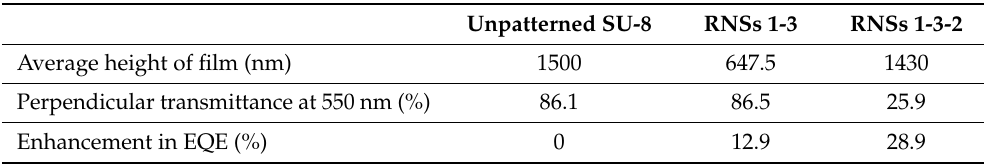
Figure 7. Comparison of light efficiency characteristics of scattering layers in which TiO 2 -diluted RNSs are applied to OLED devices. ( a ) Current density-voltage characteristics of devices, ( b ) ex- ternal quantum efficiency as a function of current density characteristics of fabricated OLEDs, and ( c ) normalized angular luminance distributions of OLEDs between 0 ◦ and 70 ◦ . Table 1. Average height of film, perpendicular transmittance, and the enhancement in EQE for different